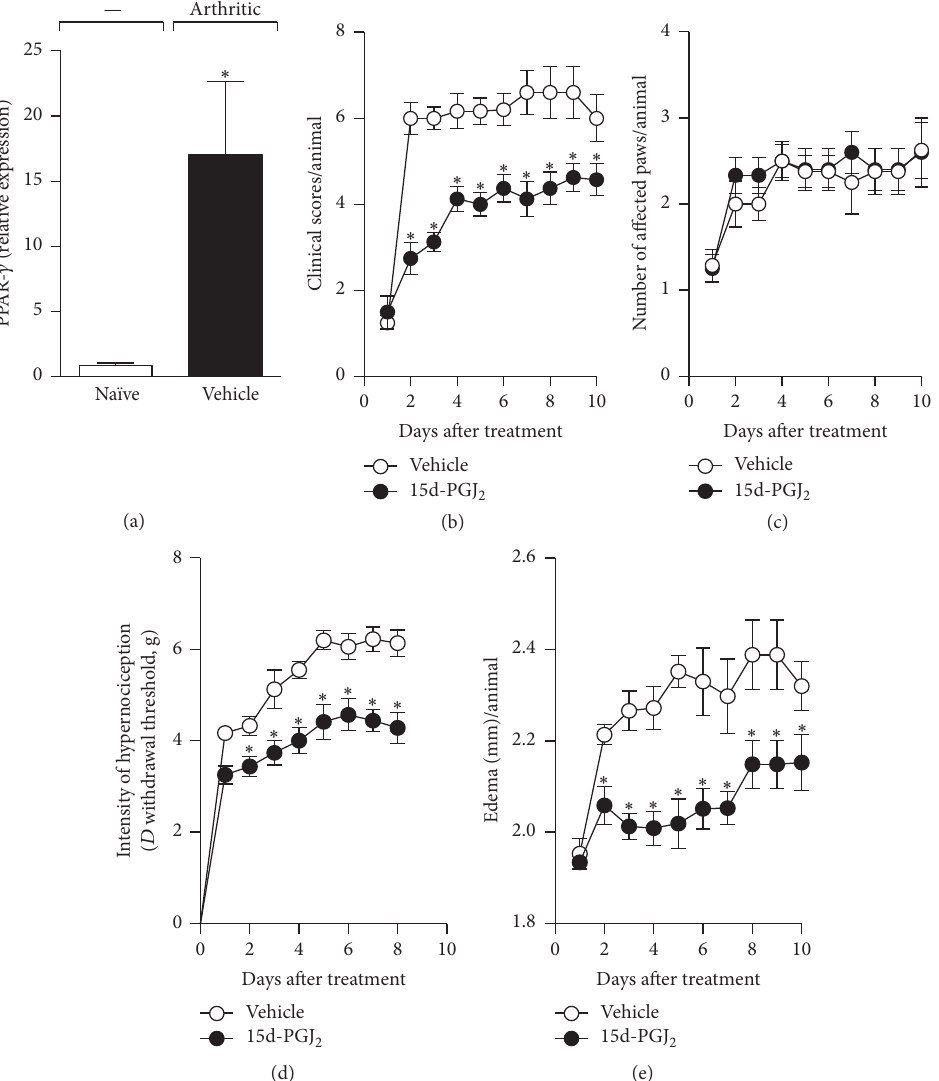
Figure 1: 15d-PGJ 2 attenuated collagen-induced arthritis. PPAR- 𝛾 mRNA expression was quantified by real-time PCR in draining lymph nodes from na¨ıve (white bar) or collagen-immunized and challenged DBA/1 (black bar) mice on the seventh day of disease (a). Arthritic mice were treated by the subcutaneous route with vehicle ( I ) or 15d-PGJ 2 (1mg/Kg) ( e ) for 7 d. Mice were monitored for disease progression as indicated by clinical scores (b), number of affected paws (c), hypernociception (d), and edema (e). Results are presented as the mean ± SEM, N = 8–10; ∗ 𝑃 < 0.05 compared with the PBS-treated